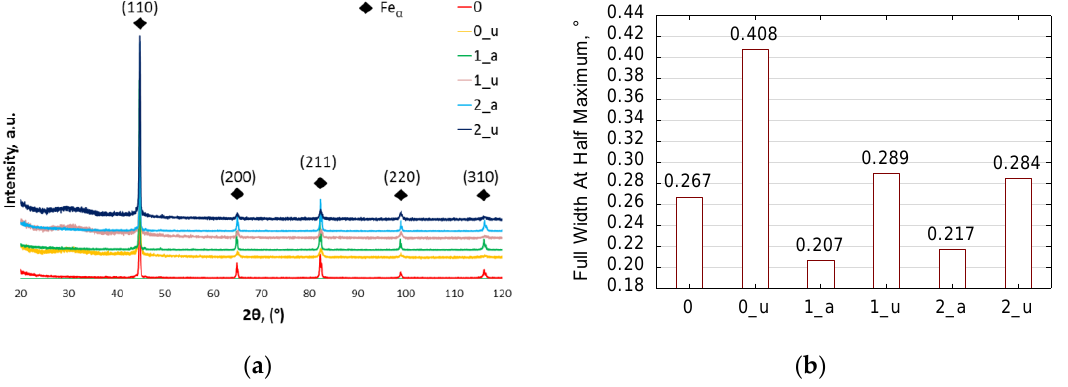
Figure 7. X-ray diffraction phase analysis of 42CrMo4 steel; ( a ) phase composition after annealing and upsetting; ( b ) quantitative microstructure phase analysis of an approximately 44 ◦ peak in the [110] plane; samples: 0—as-received; 1_a and 2_a—annealed; and 0_u, 1_u, and 2_u—upsetting; XRD.